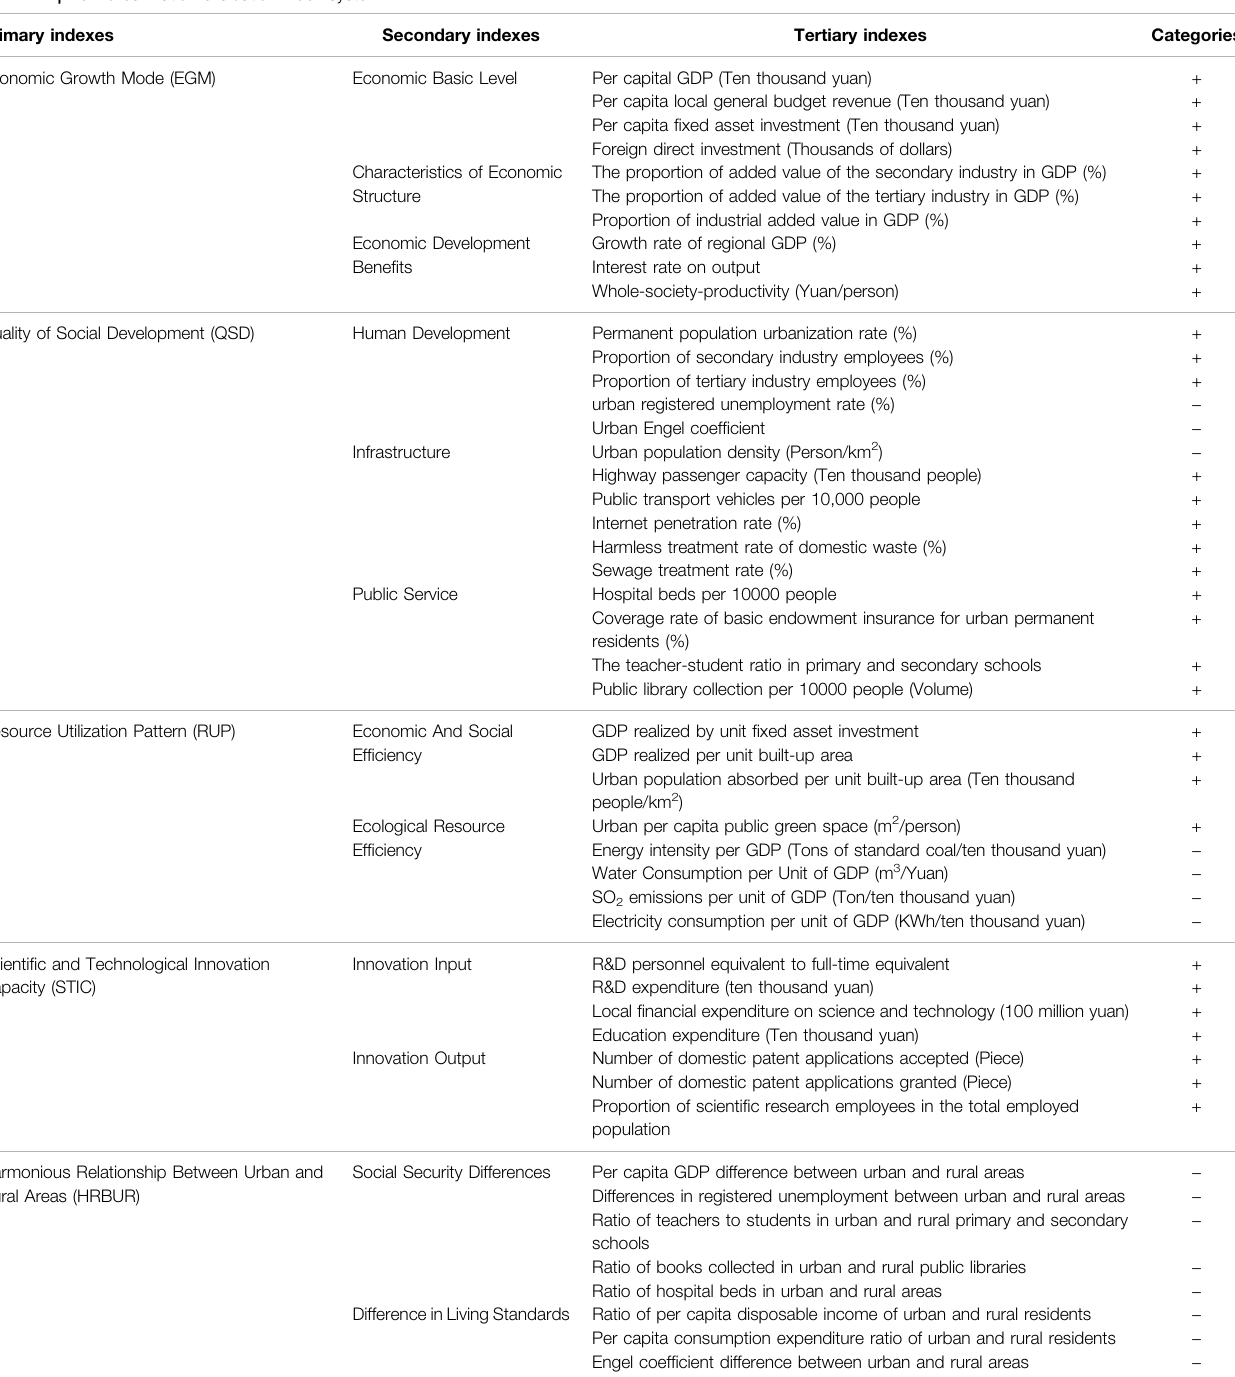
TABLE 2 | New urbanization evaluation index